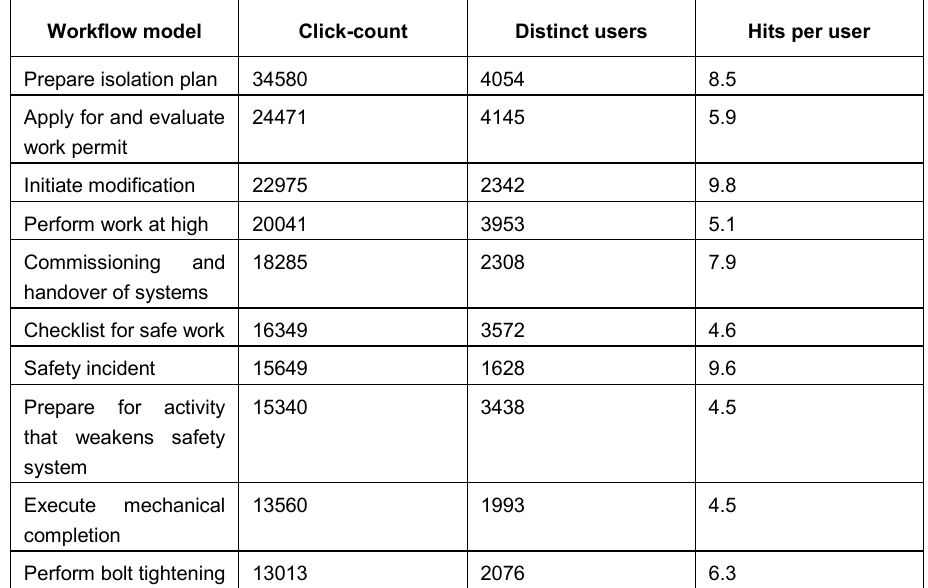
Table 1. The 10 most used process